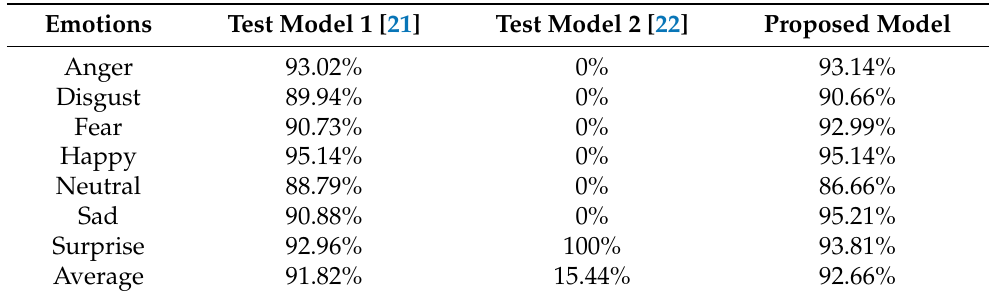
Table 15. Comparison of emotion prediction by Model 1, Model 2, and proposed model for experi- ment 1 after 100 epochs.